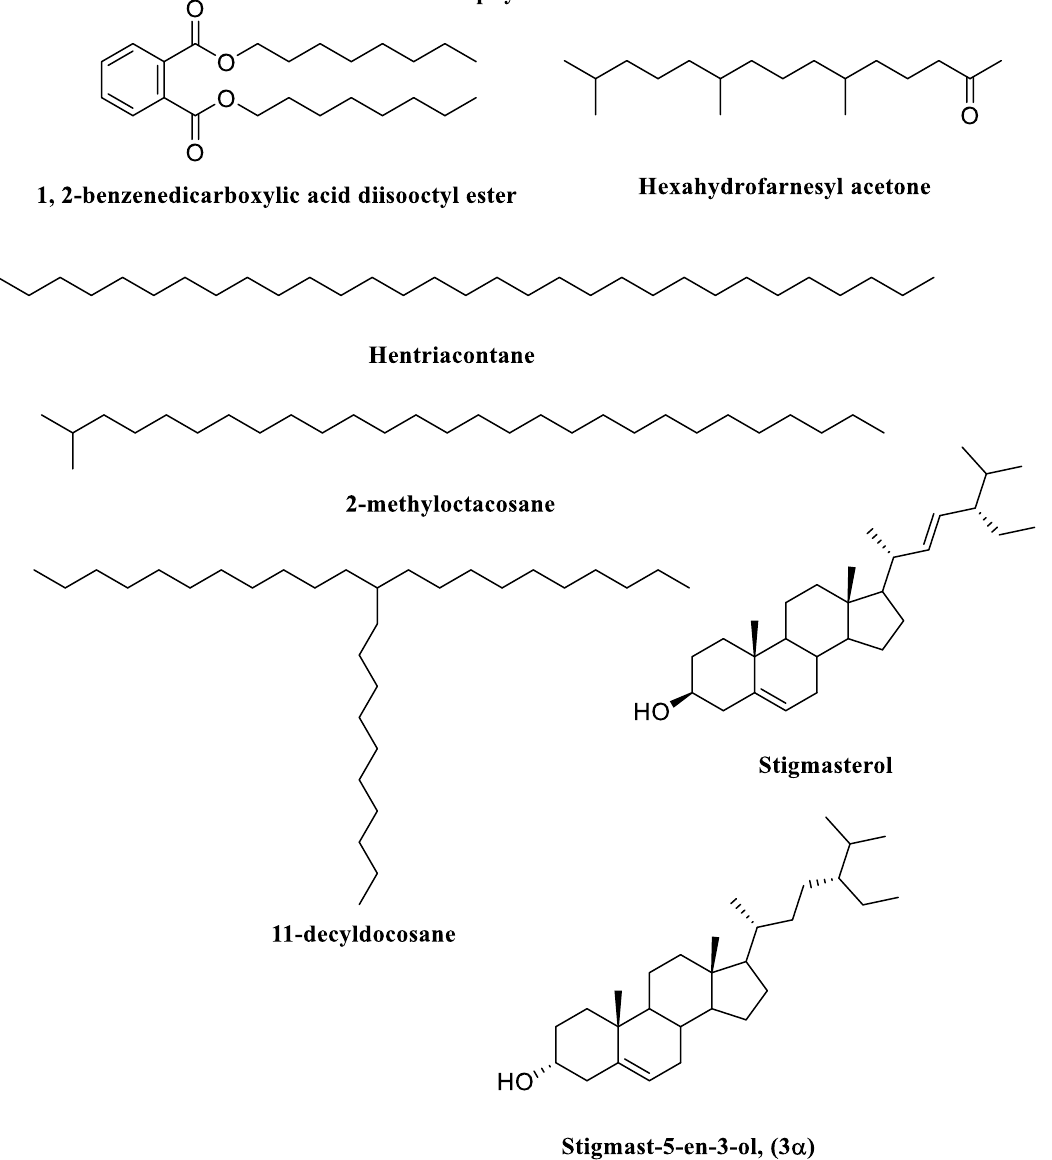
Figure 1. Structures of the major metabolites identified in the S. aegyptiaca essential oil extracts .